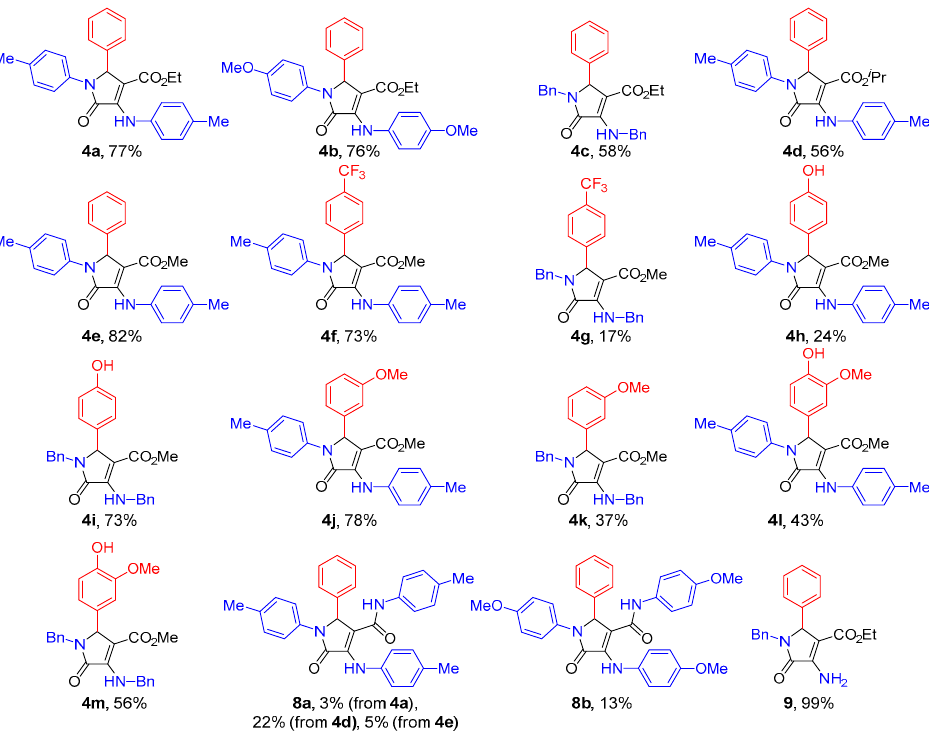
Figure 2. 3-Amino 3-pyrrolin-2-ones 4 , 8 and 9